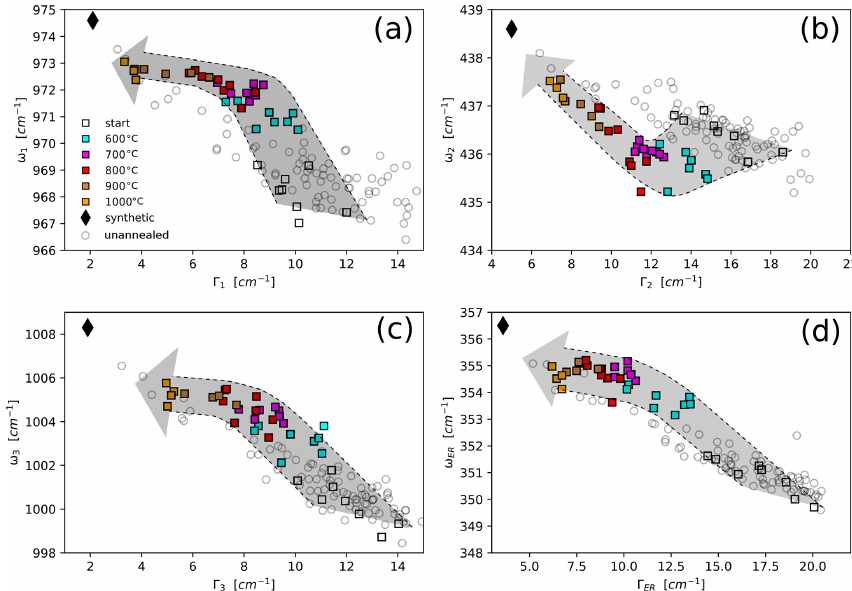
Figure 3. ω – (cid:48) plots of the ν 1 (SiO 4 ) (a) , ν 2 (SiO 4 ) (b) , ν 3 (SiO 4 ) (c) , and external rotation (ER) (d) Raman bands for the isochronal annealing runs for 1h between 600 and 1000 ◦ C. Gray circles represent the unannealed zircons from which the annealed samples were selected. The shaded arrows serve as guides, encompassing the range of subparallel annealing trajectories for the annealed zircons from different starting points. The dashed lines approximately mark the lowest- and highest-damage trajectories.